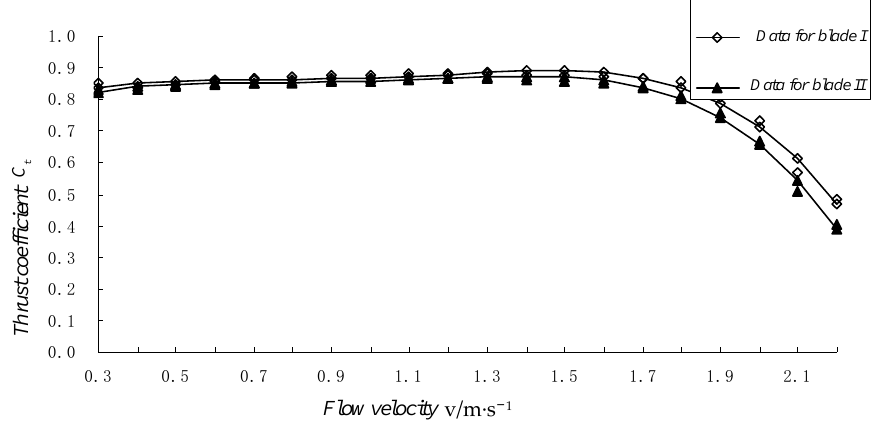
Figure 19. Thrust coefficient of blades at different flow velocities.